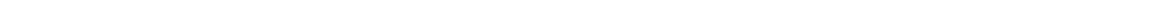
Fig. 3 GECX-MS to capture and identify UBE2D3 interacting with PCNA. a Structure of the substrate protein yPCNA (PDB ID: 4YHR) with its ubiquitination site K164 and two neighboring residues T163 and E165 shown in stick; structure of UbcH5C (PDB ID: 1 × 23), a yeast homolog of UBE2D3 (a human ubiquitin E2 enzyme), is shown at right with the active site residue Cys85 highlighted in stick. b Western blot analysis of in vitro crosslinking of UBE2D3 to yPCNA via the genetically encoded Uaa BprY or EB3 incorporated into yPCNA. An anti-His6 antibody was used to detect the His6 tag appended at the C- termini of yPCNA and UBE2D3. c Western blot of cell lysate of cells co-expressing yPCNA(165EB3) and UBE2D3, showing the in vivo crosslinking of UBE2D3 onto yPCNA by EB3. d SDS-PAGE gel of His-tag puri fi ed proteins from cells co-expressing yPCNA(165EB3) and UBE2D3. e Mass spectrum of cross-linked peptide between yPCNA and UBE2D3. U represents EB3 in the peptide sequence. f Mass spectrum of biotinylated cross-linked peptide between yPCNA and UBE2D3. U represents EB3 in the peptide sequence. g Extracted ion chromatography of biotinylated cross-linked peptide from input sample of biotin enrichment. RT: retention time; MA peak area, MH peak height. h Extracted ion chromatography of biotinylated cross-linked peptide